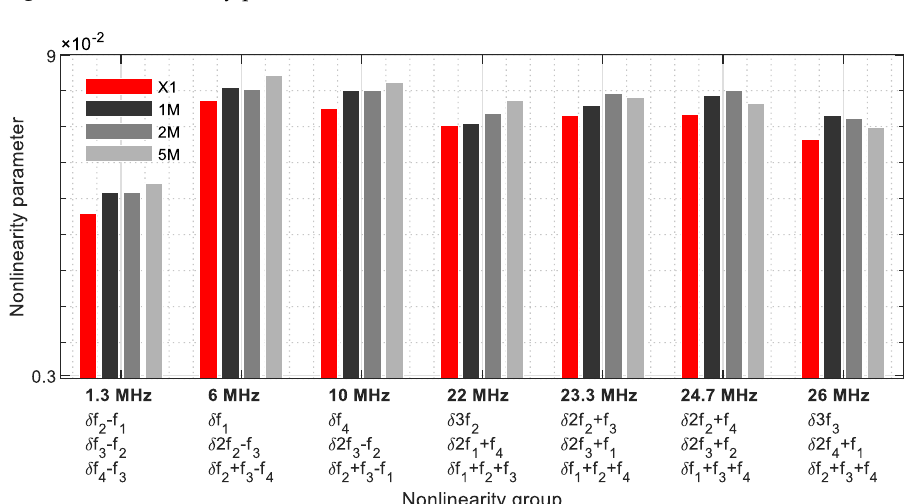
Figure 23. Nonlinearity parameter — δ G3 .